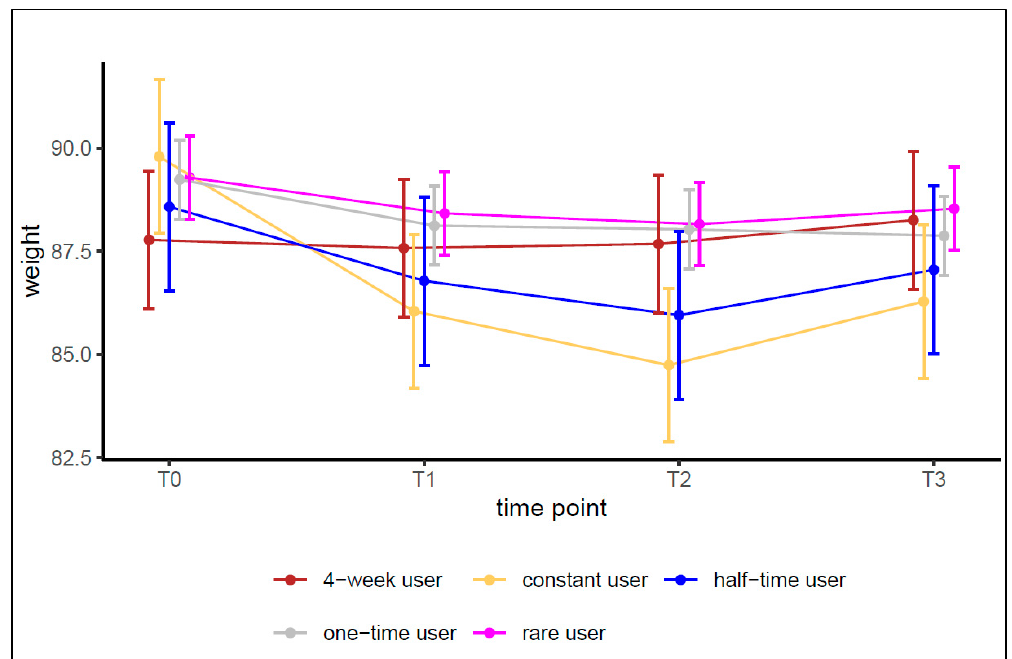
Figure 4. Adjusted weight change by user type, ITT sample.